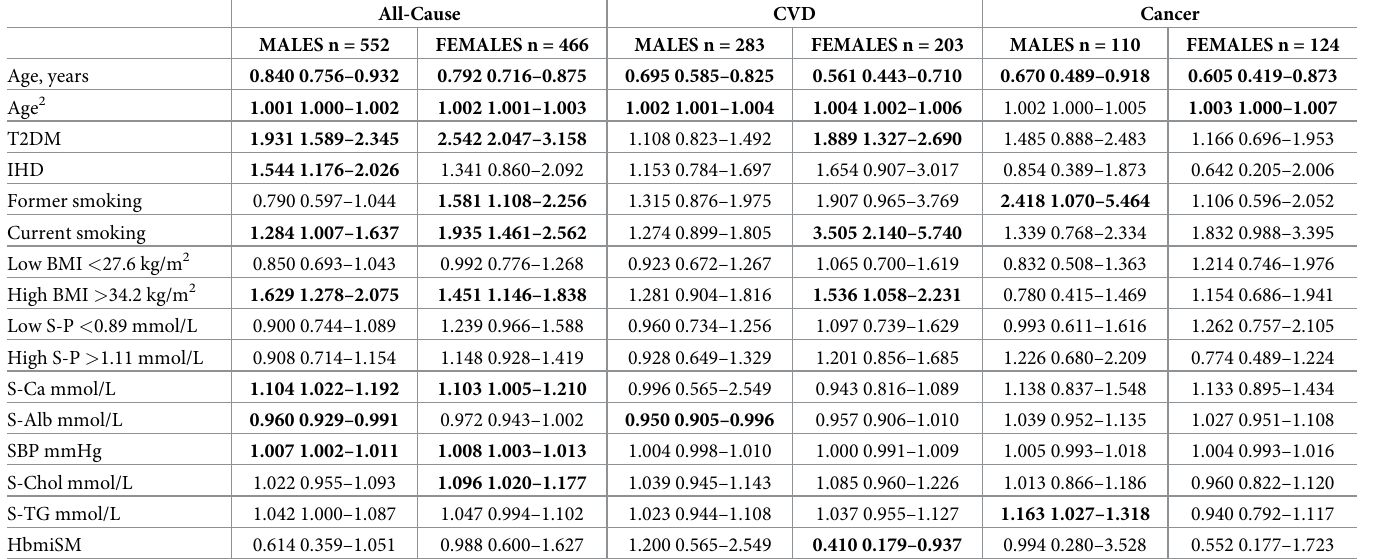
Table 3. Cox regression; HR (95%CL) for all-cause, CVD and cancer mortality (n = deceased).